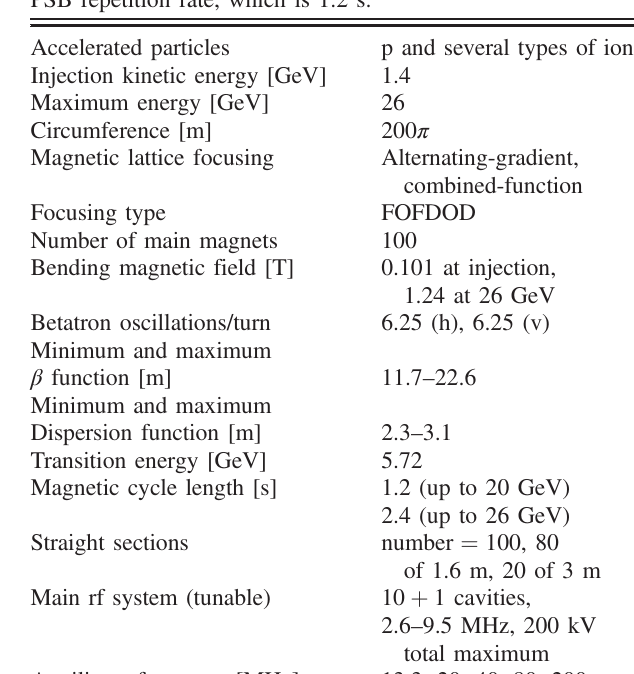
cases are shown: one corresponding to the standard cycle configuration (blue) and one for the optimized cycle (red).